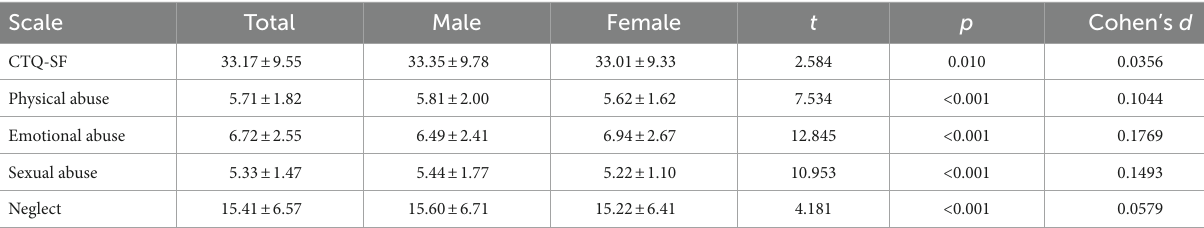
TABLE 5 Scores of the alternative CTQ-SF and the four subscales by sex (Mean ±